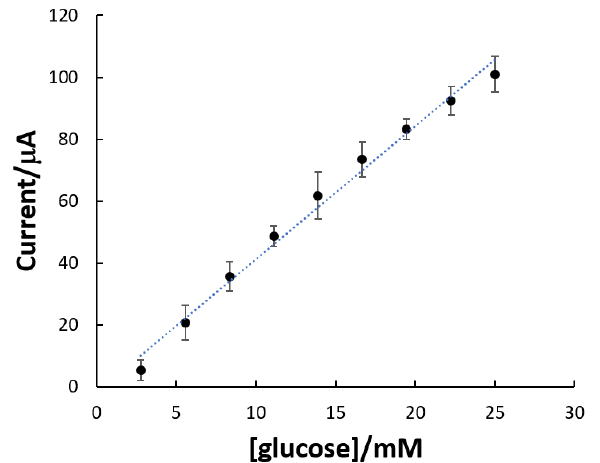
Figure 2. The dependence of the current response versus the concentration of plasma glucose at PQQ-GDH/MWCNTs bioanode. the error bars represent standard errors of the mean triplicate values.